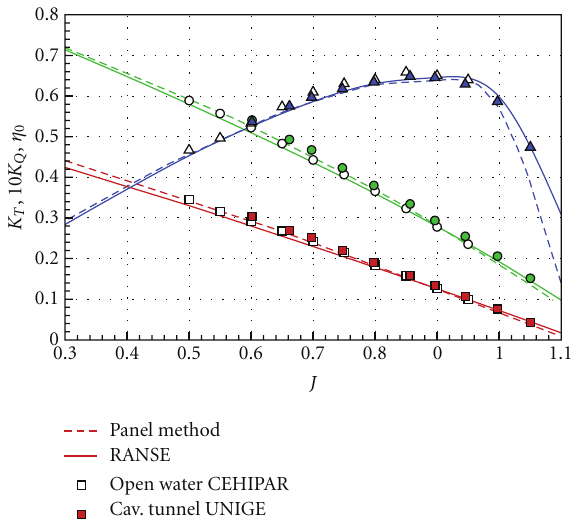
Figure 12: Open water propeller characteristics. RANSE and panel method in model scale compared with experimental towing tank/cavitation tunnel